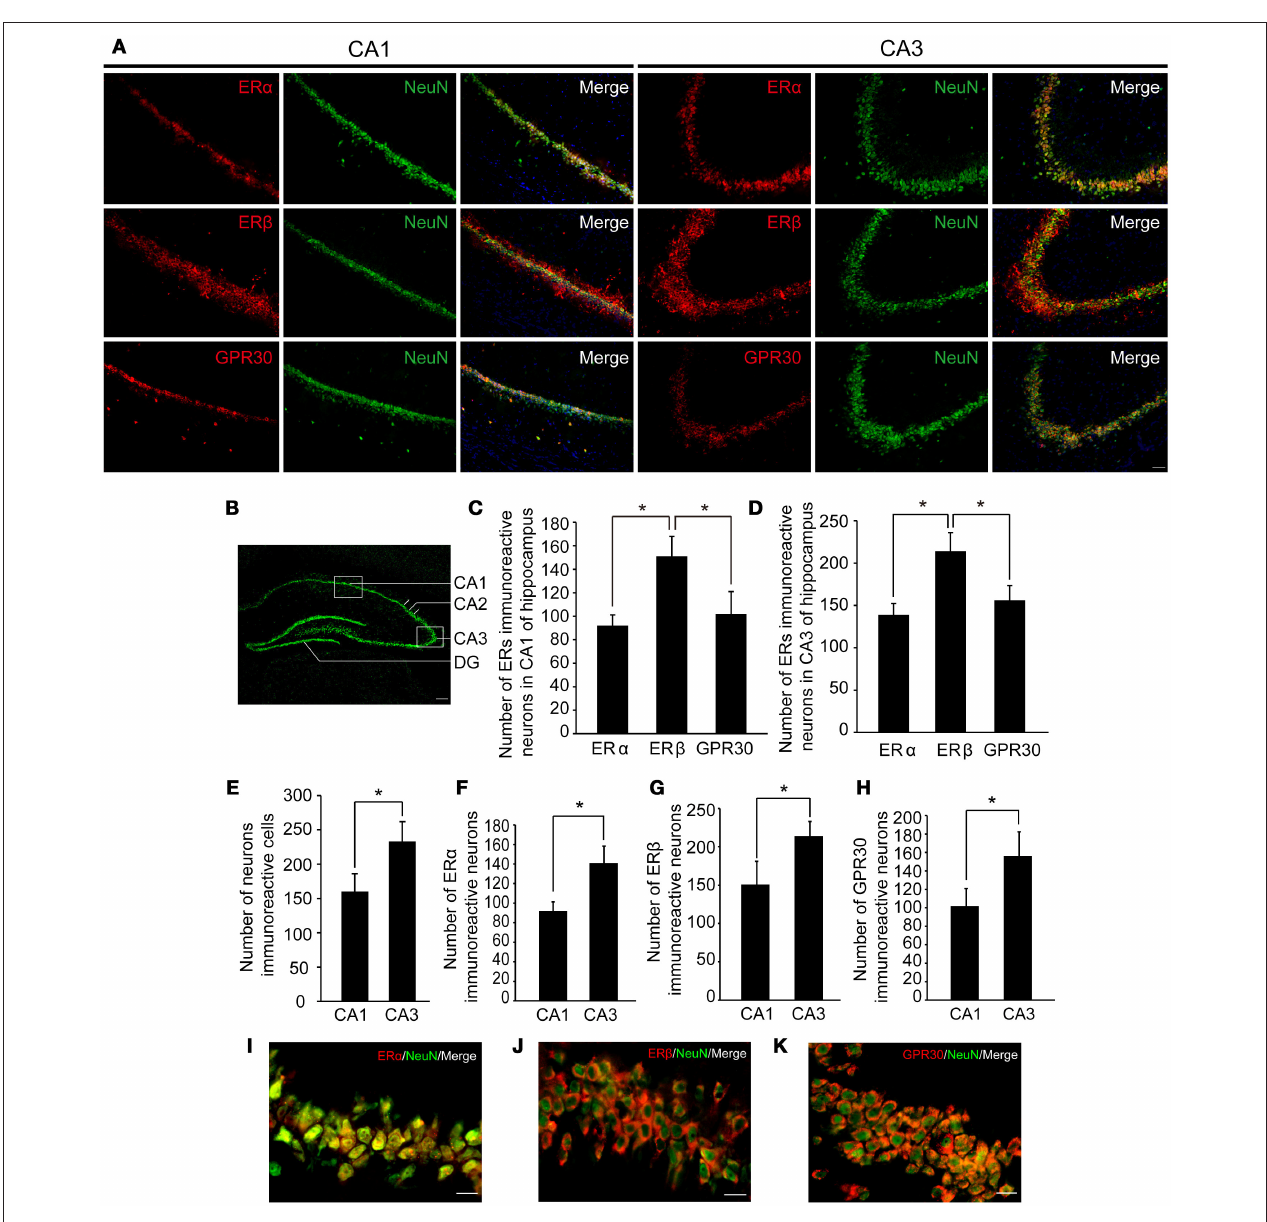
FIGURE 4 | Expression of three types of ERs in hippocampus. (A) Immunofluorescence staining in hippocampal CA1 and CA3 regions (boxed region in B ) showing ERs (red), neurons (green), and nuclei stained with DAPI (blue). Scale bar = 50 µ m. (B) A portion of one side of the hippocampus marked by NeuN. Scale bar = 200 µ m. (C–H) The number of ER immunoreactive neurons and neurons in the hippocampal CA1 and CA3 regions; n = 4; * P < 0.05. (I–K) Colocalization of ERs with NeuN at higher-magnification views. Scale bar = 20 µ m. ER, estrogen receptor; GPR30, G protein-coupled estrogen receptor.